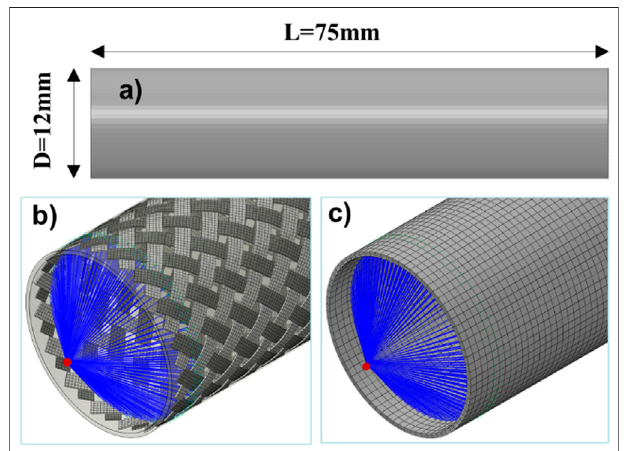
FIGURE 8 | The FE model of the nuclear cladding tube: (A) the dimension of the tube with a thickness of 0.3 mm; (B) the braided mesh integratedwiththematrixmeshusingembeddedconstraint; (C) thelaminated tube. The global fi ber volume fractions are identical of 28%. The boundary conditions are applied to the master nodes using the continuum distributing constraints.